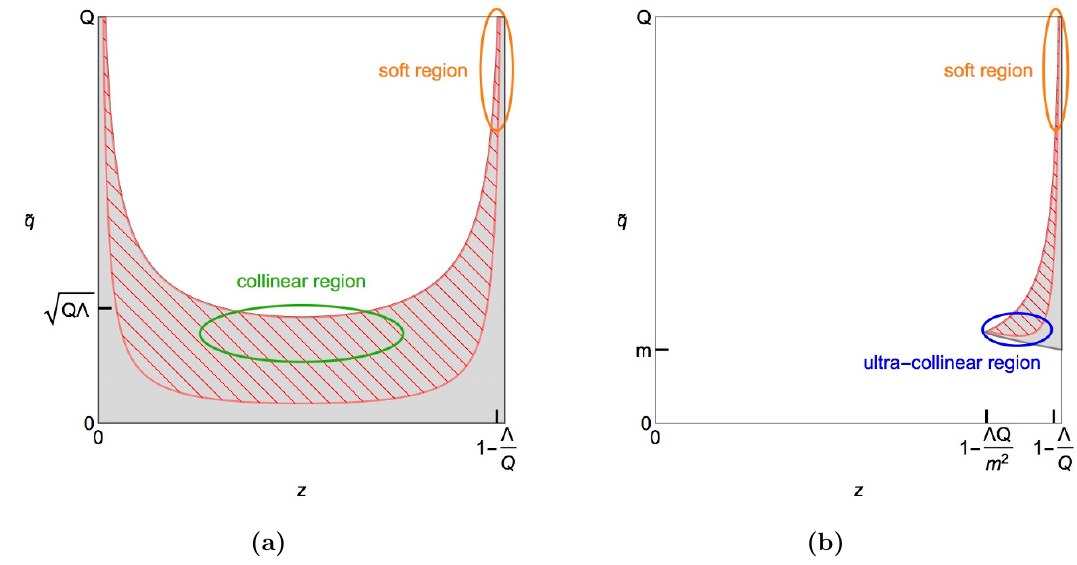
Figure 4. ( z; ~ q ) phase space for coherent branching in the (a) massless and (b) massive case, with indication of the relevant soft, collinear and ultra-collinear regions. The hatched area corresponds to the phase space populated in the presence of a shower cut Q 0 . The soft, collinear and ultra-collinear phase space regions are